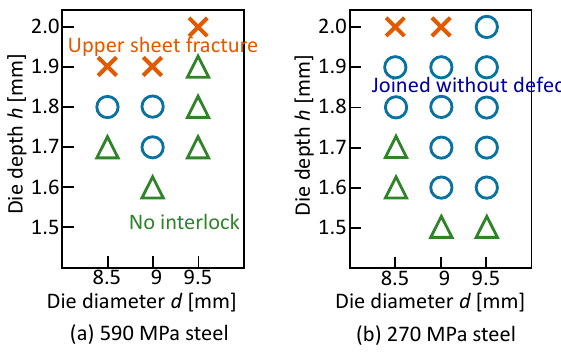
Figure 25. Joining ranges for ( a ) 590 MPa and ( b ) 270 MPa steel sheets.